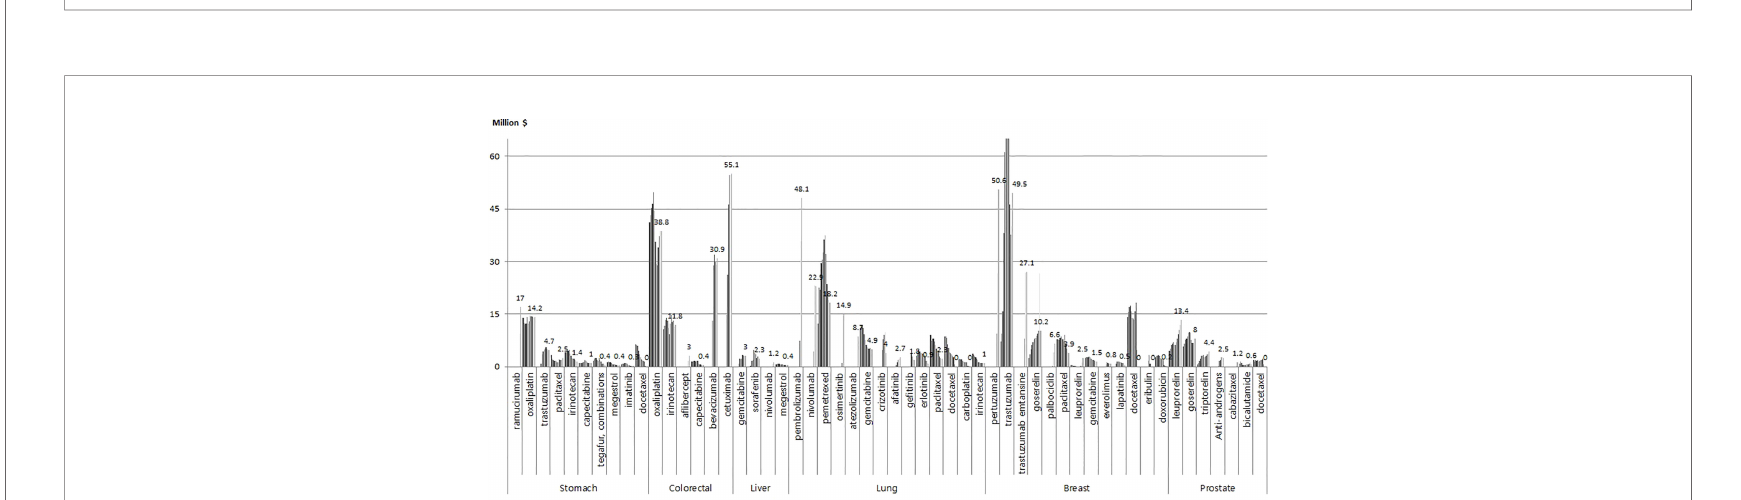
FIGURE 1 | Trends in total healthcare spending by cancer type and year (USD).